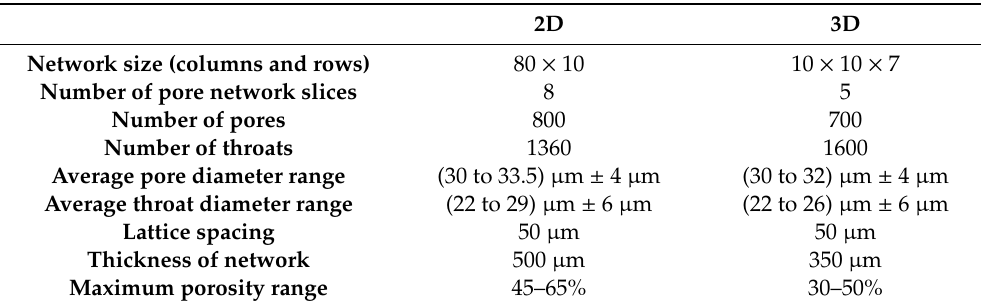
Table 1. Overview of simulation parameters.